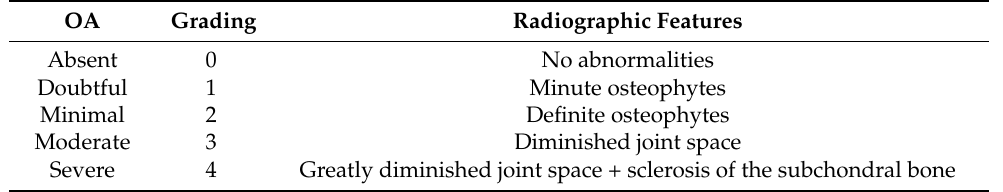
Table 3. The Kellgren–Lawrence grading of osteoarthritis for the knee